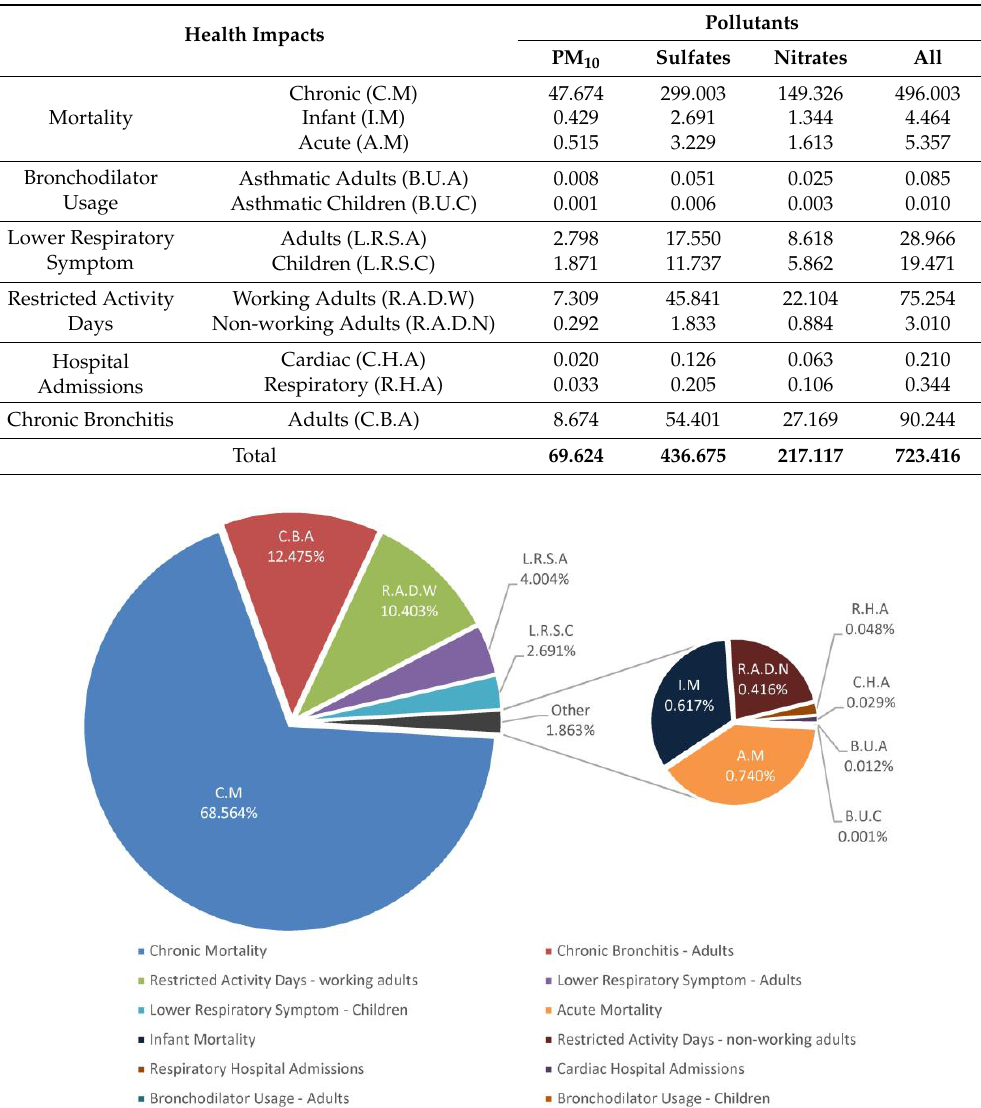
Figure 8. Share of each health impact in total damage costs from all the 61 power plants.